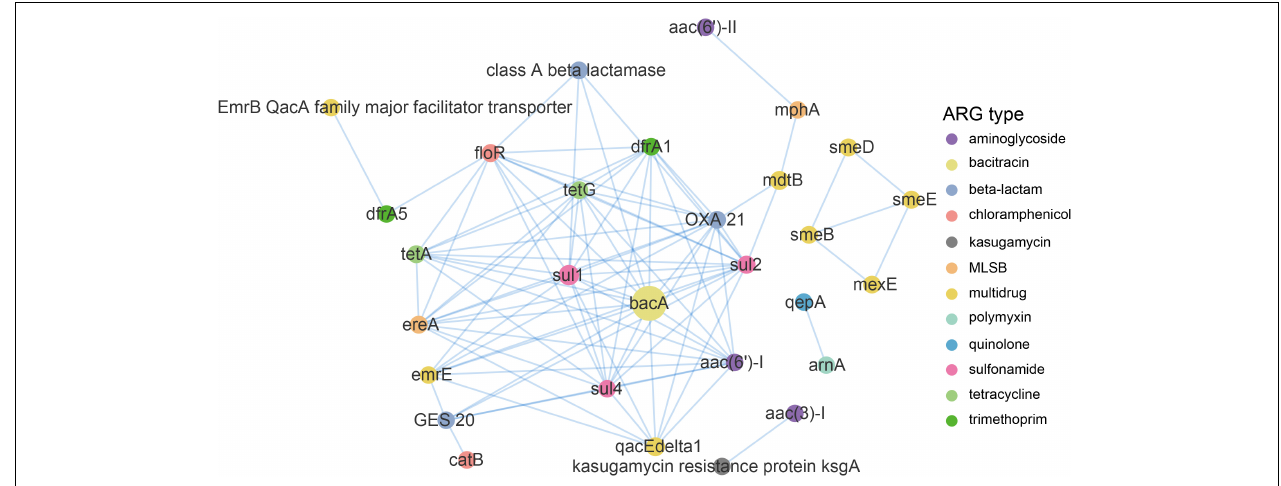
FIGURE 6 | Network analysis demonstrating the co-occurrence patterns of ARG subtypes in the DWTS. The nodes were colored according to network modularity, and the node size is proportional to the number of connections (degree). An edge is a strong ( ρ > 0.8) and significant ( p -value < 0.01) connection between nodes.